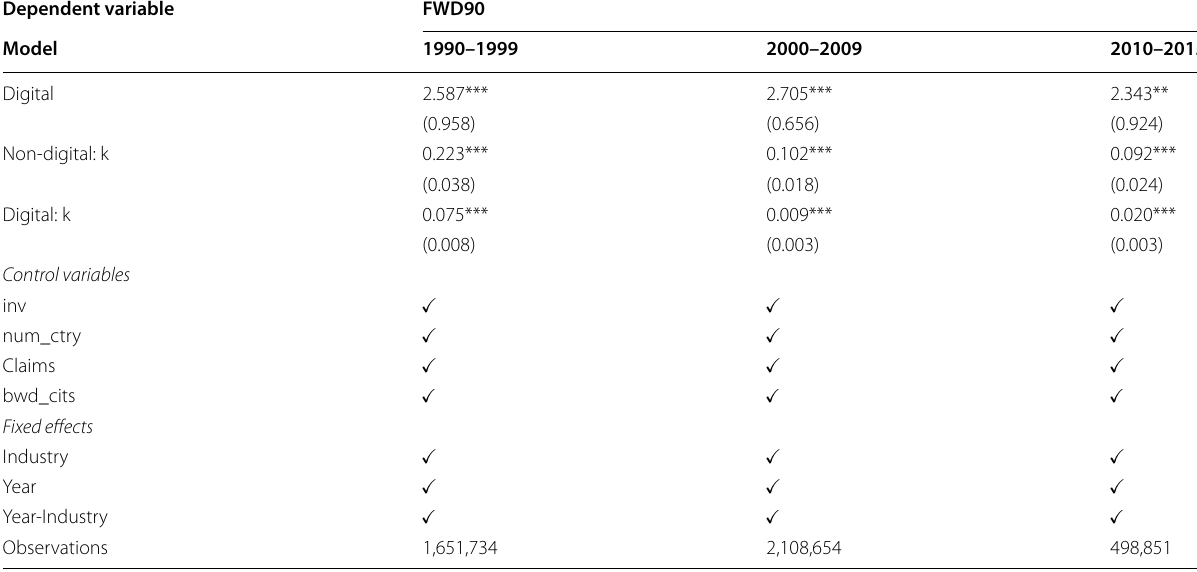
Table 7 Technological improvement rates and breakthrough innovations: time period estimates